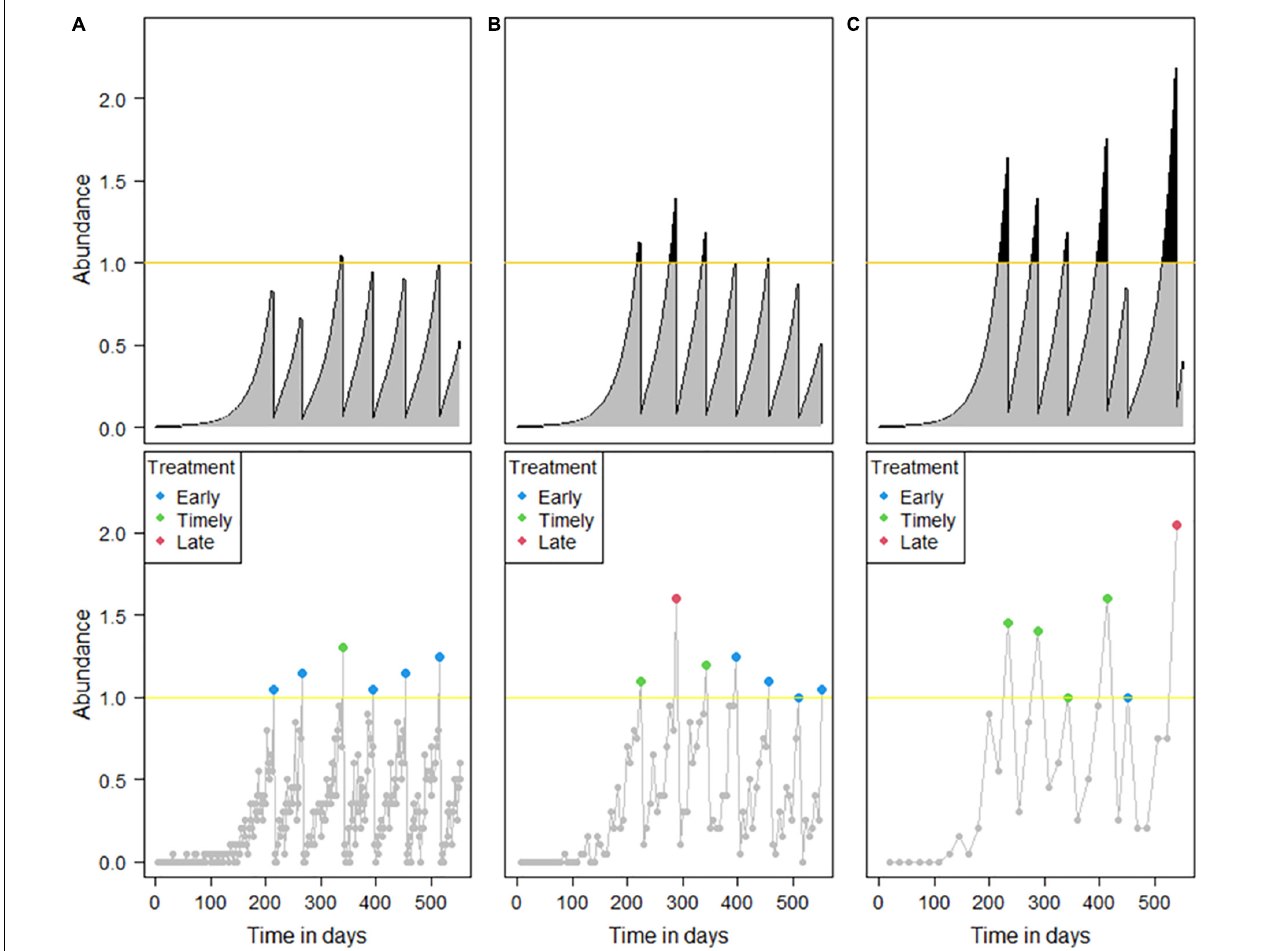
FIGURE 6 | Example simulations that show the effect of the different sampling intervals. The framework is the same as that in Figure 1 . Sampling intervals of (A) 2, (B) 6, and (C) 18 days were simulated with a sample size of 20.